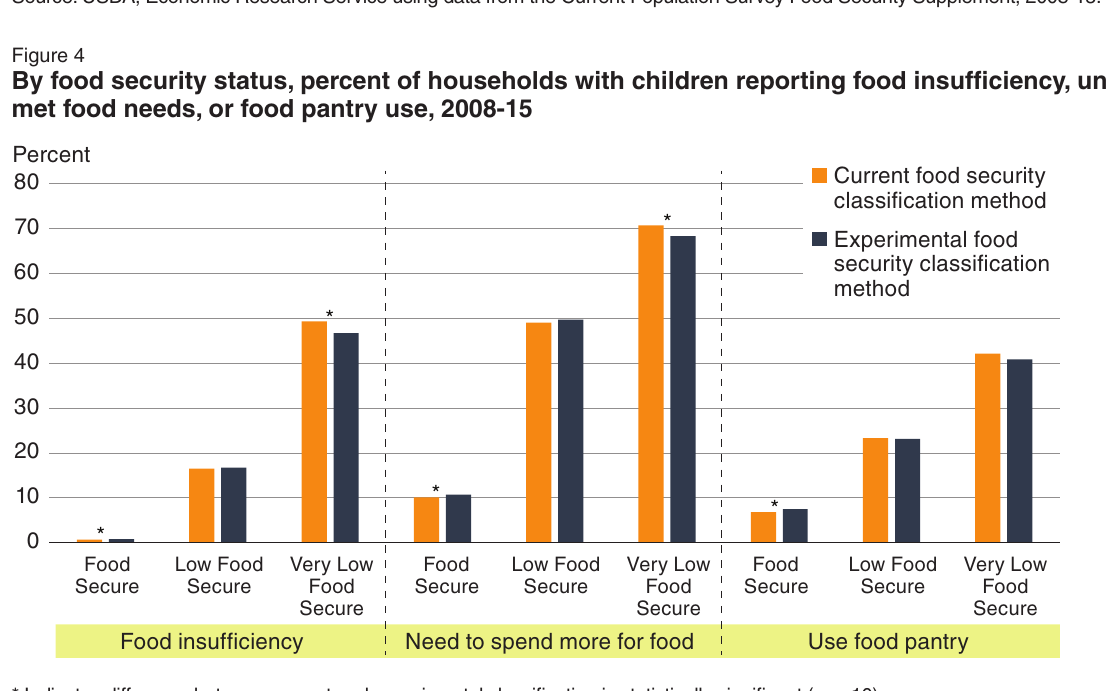
Asterisks show statistically significant difference as follows: * = p < 0.05. Estimates are weighted to represent the U.S. population. N=34,249